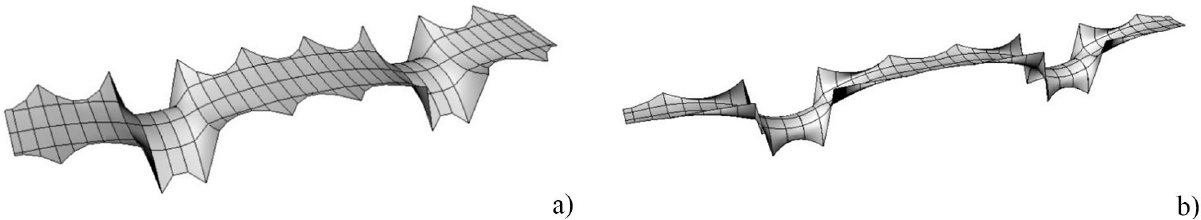
Figure 3: Form-finding of the Basento Bridge using simulated annealing: (a) with isotropic curvatures; (b) after reduction of transverse curvatures